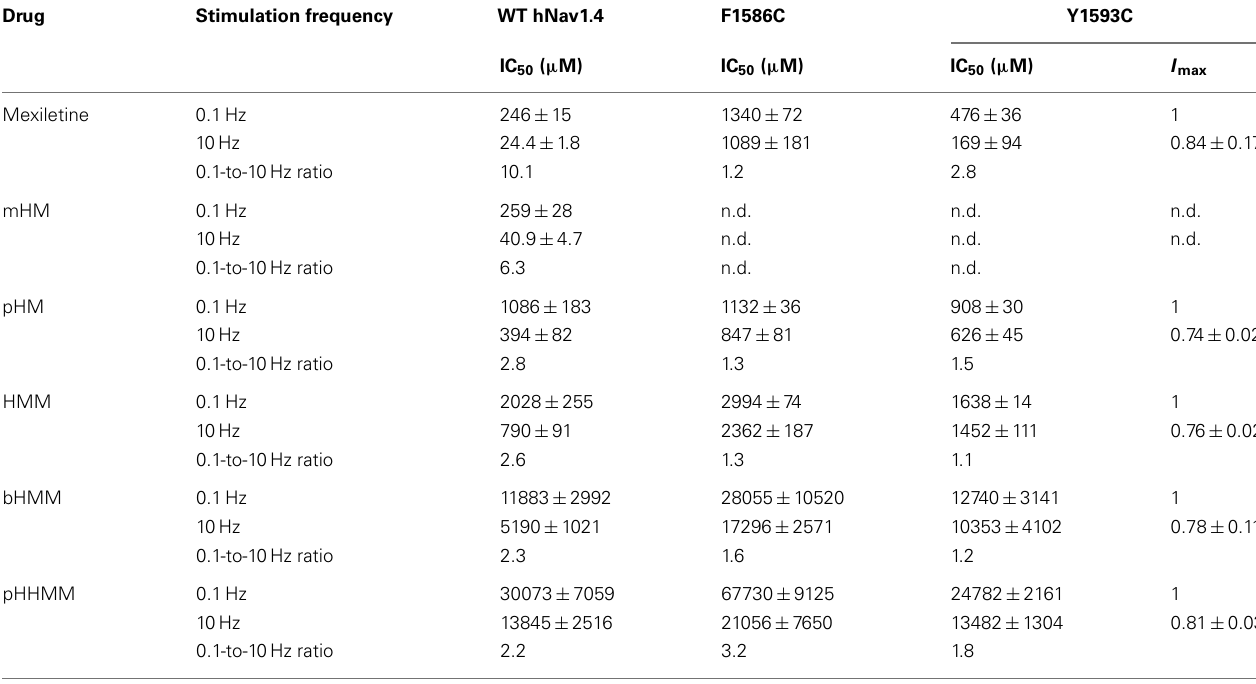
Table 2 | Half-maximum inhibitory concentration values (IC 50